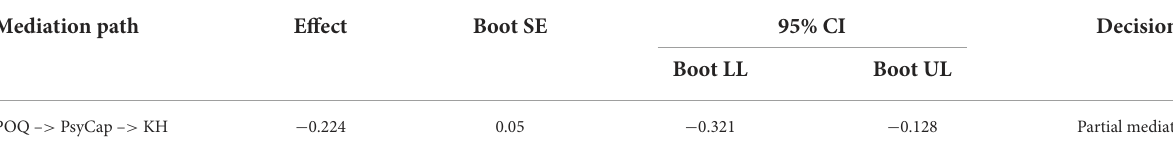
TABLE 6 Overall summary of mediation